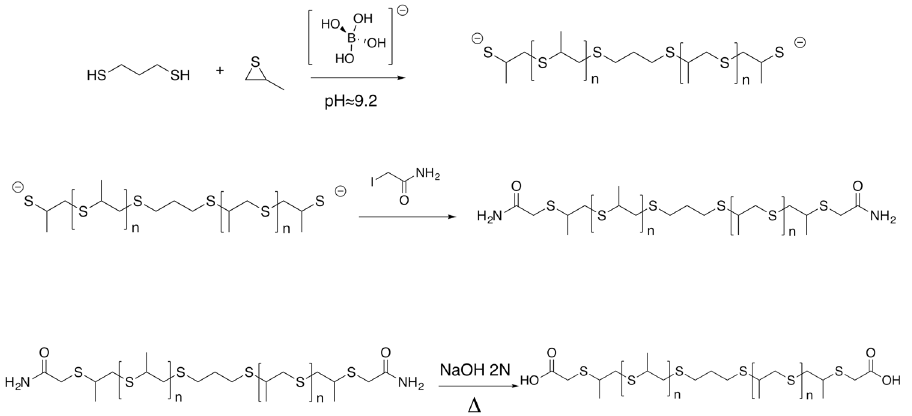
Figure 7. Synthesis of the polypropylene sulfide polymer.